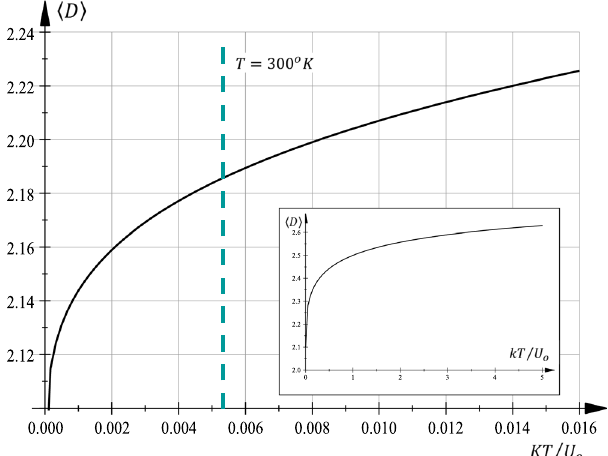
Figure 2. Graphene spatial averaged dimension 〈 D 〉 as function of dimensionless temperature kT / U o , where U 0 = ℏ v F / a . For 300 °K the fractional dimension becomes ~2.1872 (vertical dashed line). Inset, a graph showing the tendencies for dimension as a function of temperature. In fact, 〈 D 〉 → 2 when T → 0 and 〈 D 〉 → 3 when T → ∞